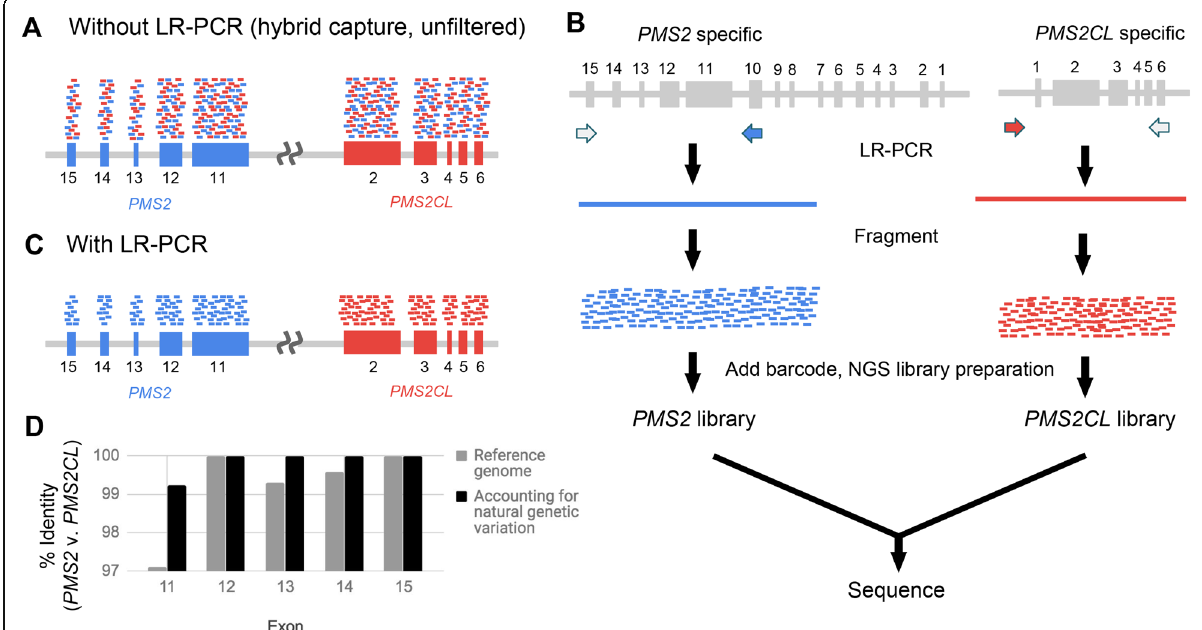
Fig. 1 LR-PCR strategy for building a dataset of natural genetic variation in PMS2 and PMS2CL . a Short-reads from NGS hybrid-capture data that originate from the gene (blue) and pseudogene (red) align to both the gene and pseudogene due to high homology. b, c Using LR-PCR that is specific to the gene or pseudogene followed by fragmentation and barcoding ( b ), the resulting short NGS reads can be assigned to the gene or pseudogene ( c ). d Percent identity between the gene and pseudogene for PMS2 exons 11 – 15 based on the hg19 reference genome (gray) and after accounting for natural genetic variation obtained from LR-PCR samples